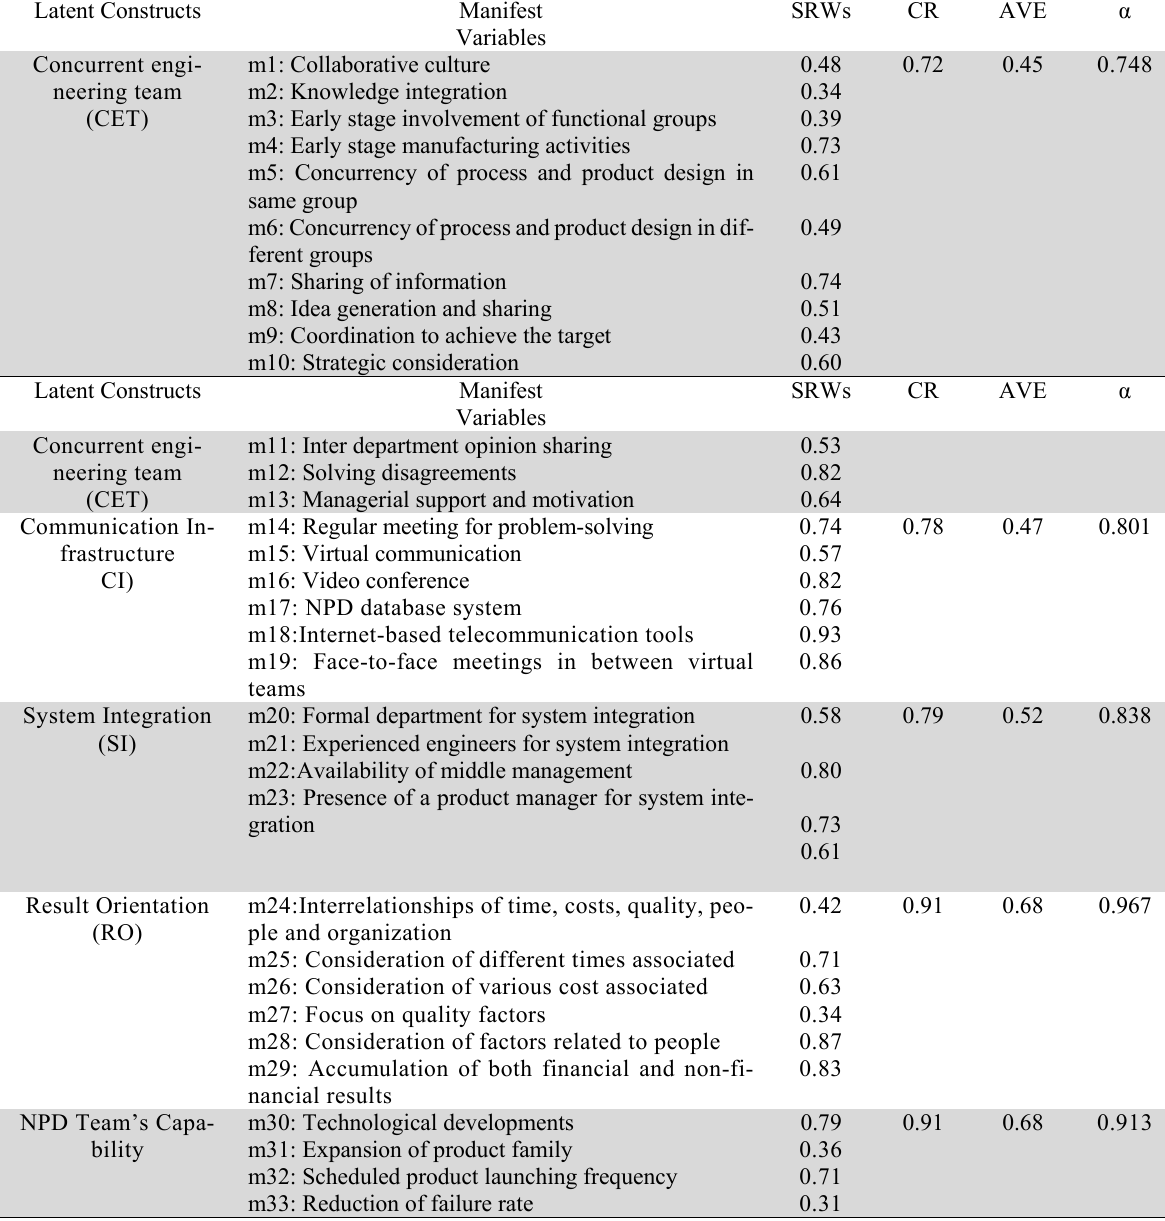
List of latent constructs along with their manifest variables including regression weights and reliability indices Latent